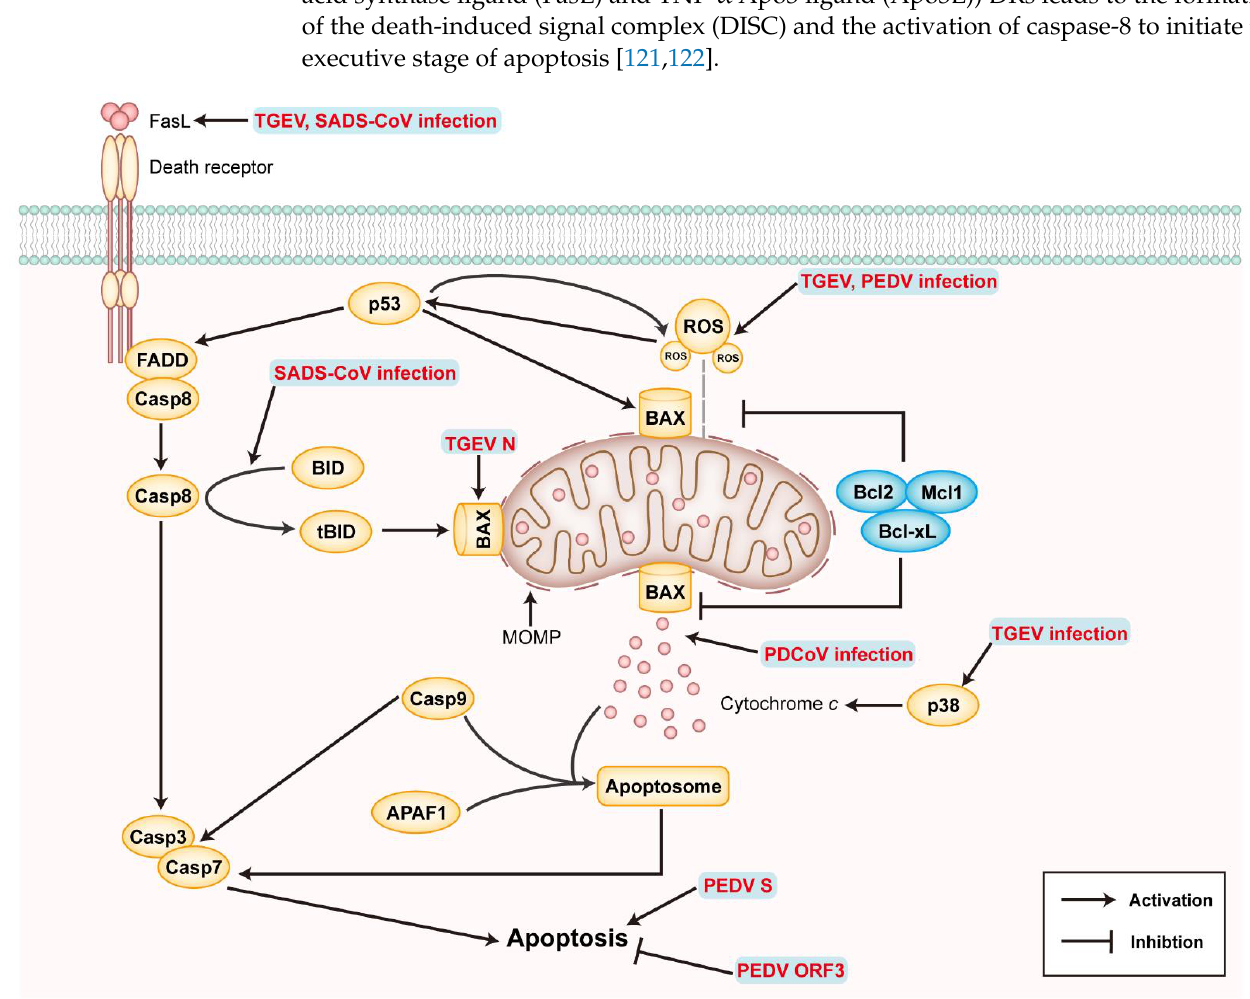
Figure 5. Apoptosis induced by SeCoV infection and modulatory mechanisms. Schematic diagram showing the signaling pathways of intrinsic and extrinsic apoptosis and the modulatory mechanisms during SeCoV infection. The yellow ovals are proapoptotic proteins, whereas the blue ovals are antiapoptotic proteins. The viral or viral components involved in the modulation of apoptosis are shown in bold red in the figure. Abbreviations: FADD, Fas-associated via death domain; BID, BH3-interacting domain death agonist; BAX, Bcl2-associated X; Mcl1, myeloid cell leukemia 1; and APAF1, apoptotic peptidase-activating factor 1.